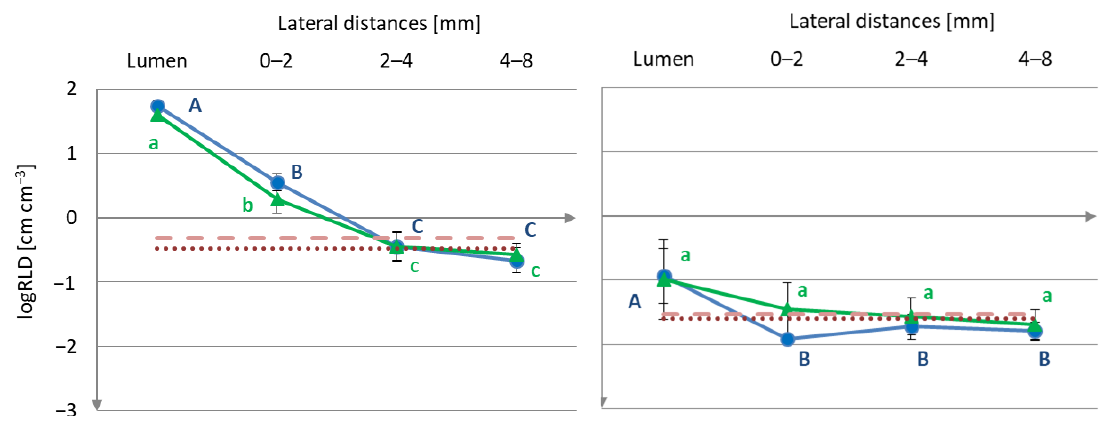
Figure 2. Log10-transformed RLD [cm cm − 3 ] of spring oilseed rape and faba bean in different biopore types (worm type = blue; root type = green). Mean and SE of lateral distances. Means not sharing a common letter indicate significant differences between lateral distances (Tukey- HSD, α = 0.05); Uppercase letters show differences for worm type and lowercase letters for root type. Red lines show the mean of the bulk soil sample for the root ( ) or worm type ( ) treatment.